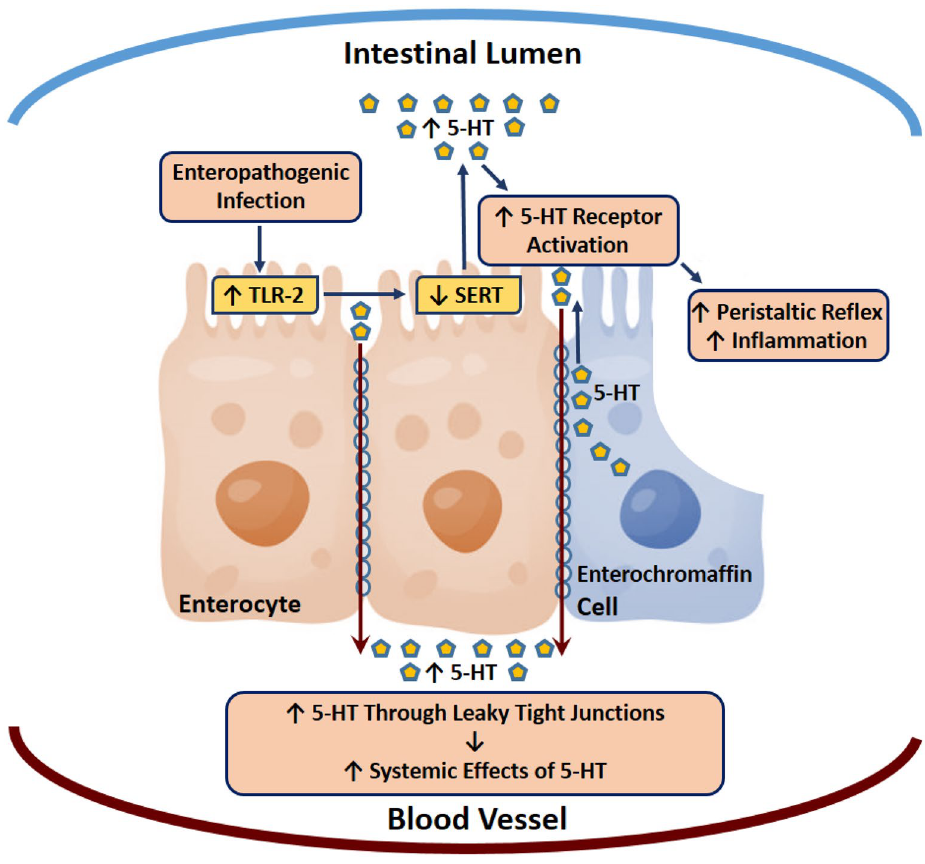
Figure 8. Proposed mechanism for increasing intestinal and serum 5-HT among CD patients. Enterochromaffin cells release 5-HT into the intestinal lumen. Under normal conditions, SERT activity is